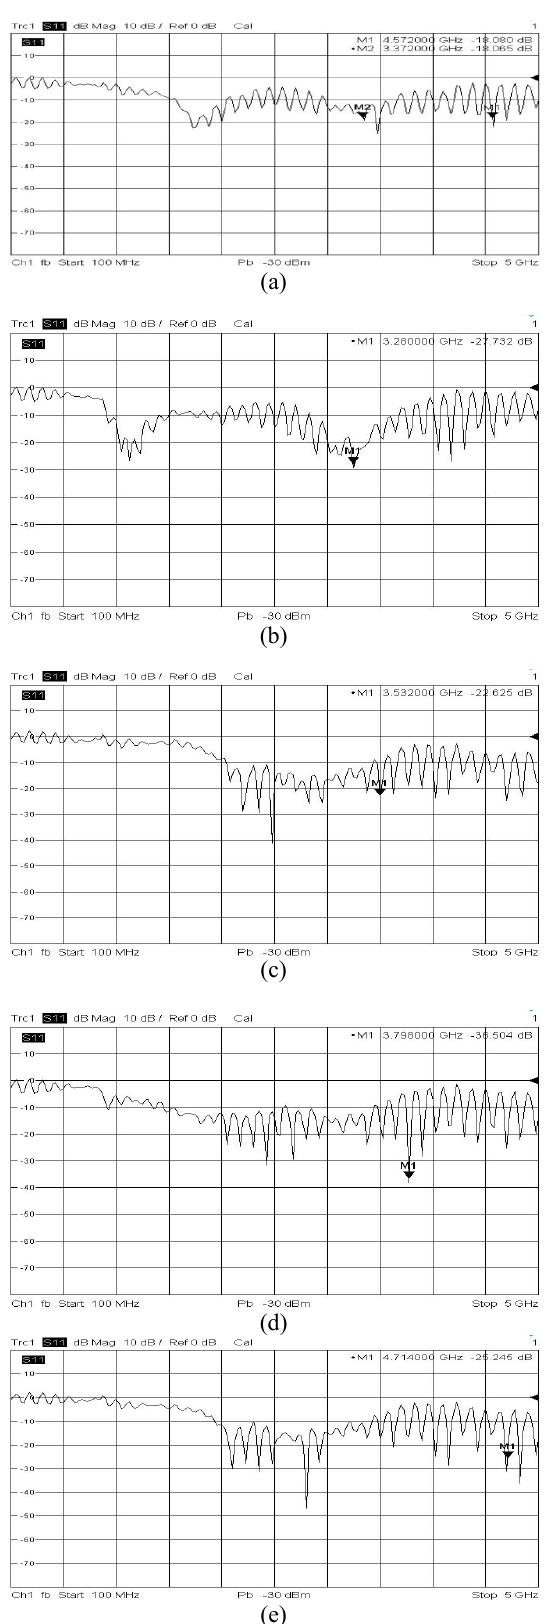
(e) FIGURE 11. Measured Reflection Coefficient of (a) Whole band (b) Sub-band1 (c) Sub-band2 (d) Sub-band3 (e)